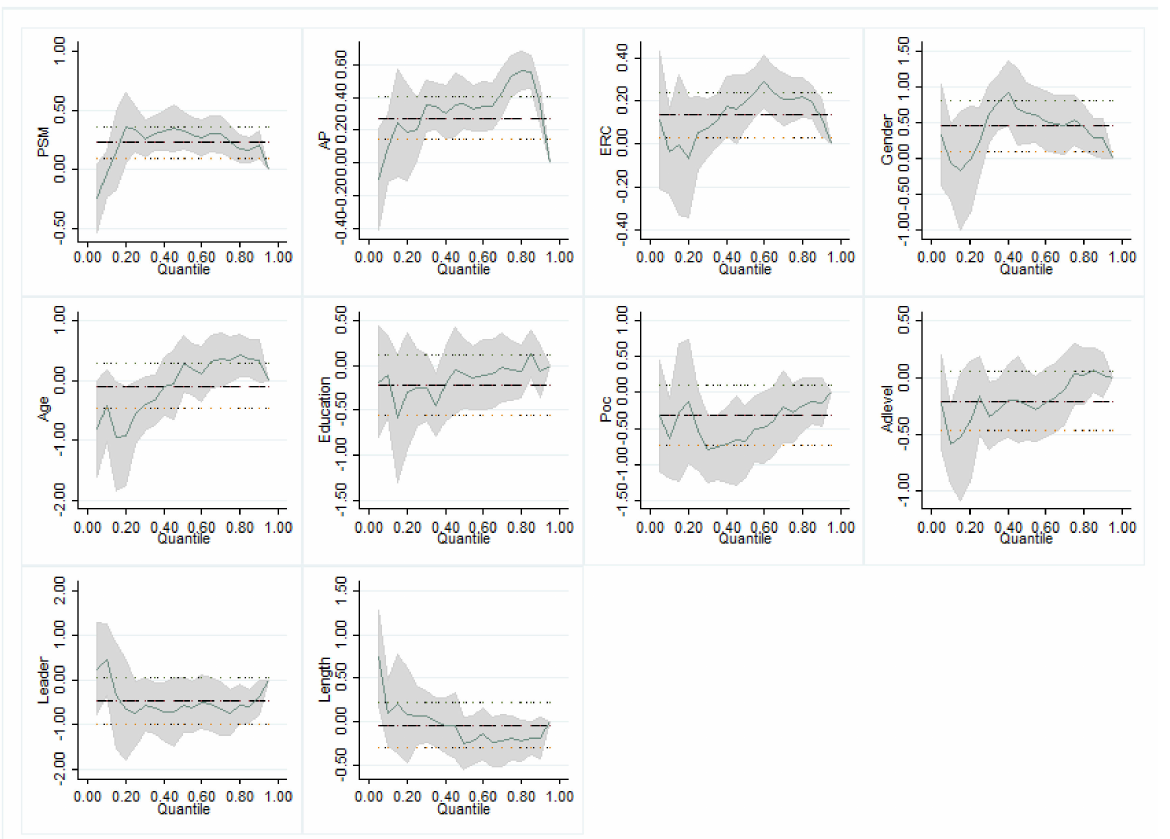
Figure 2. Quantile regression coefficient trends of explanatory